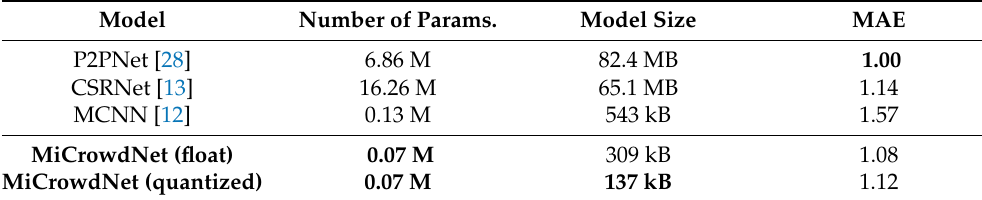
Table 1. Performance of various crowd-counting DNNs on the PRW dataset. Models were trained and tested using patches of 64 × 64 from 640 × 480